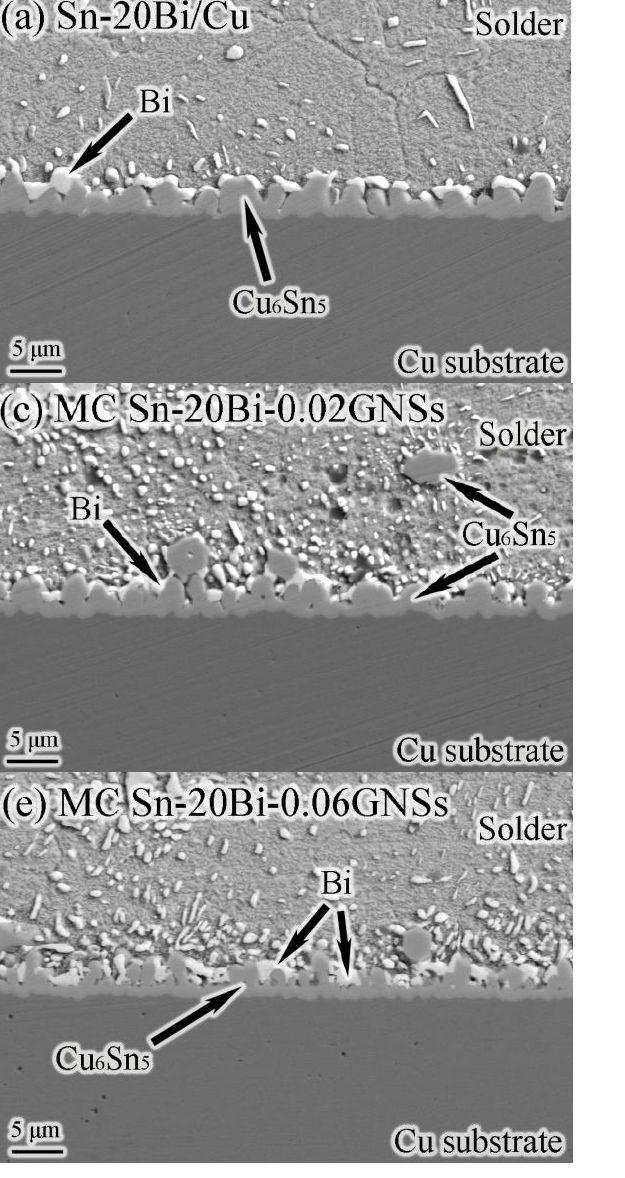
Figure 6. SEM images of MC Sn-20Bi- q GNSs/Cu solder joint cross section: ( a ) q = 0, ( b ) q = 0.01, ( c ) q = 0.02, ( d ) q = 0.04, ( e ) q = 0.06, and ( f ) q = 0.10.